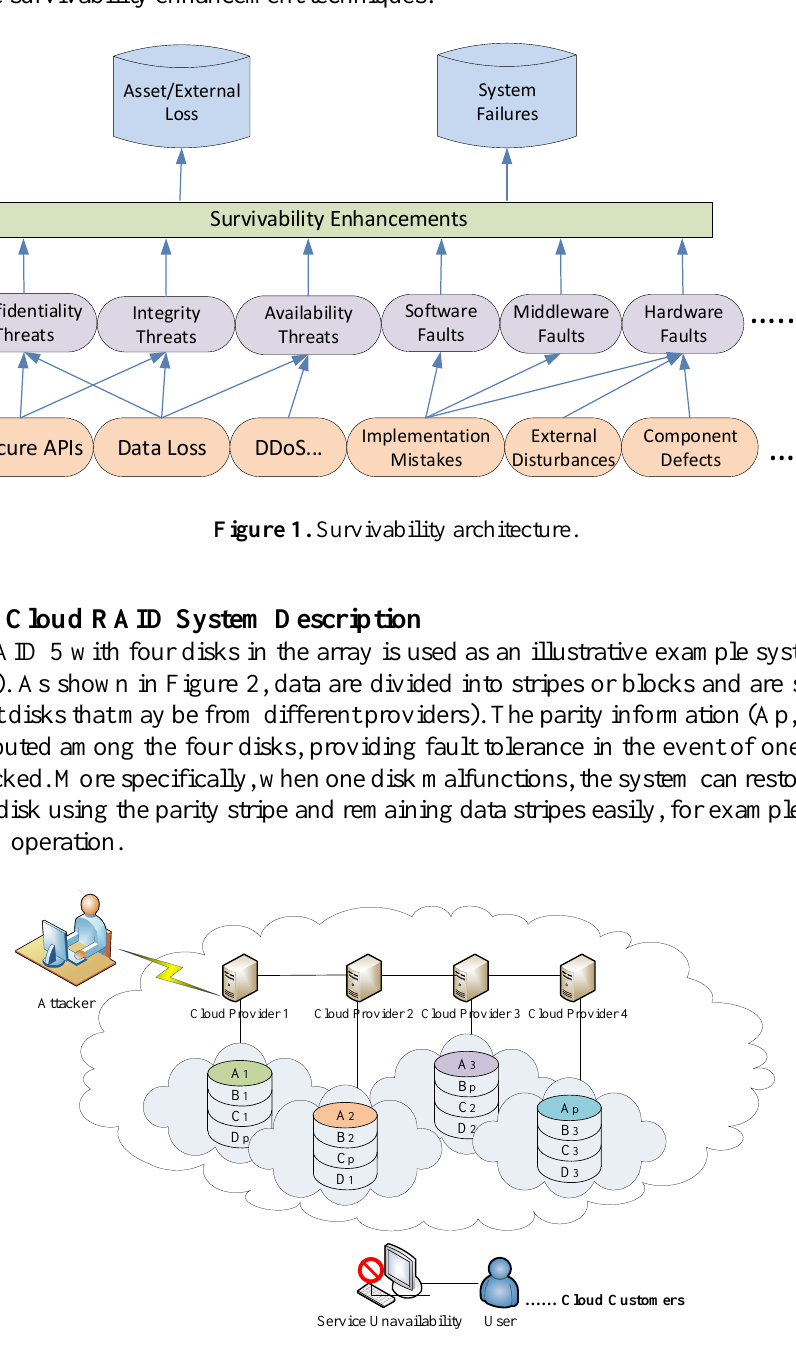
Figure 2. An example cloud RAID 5